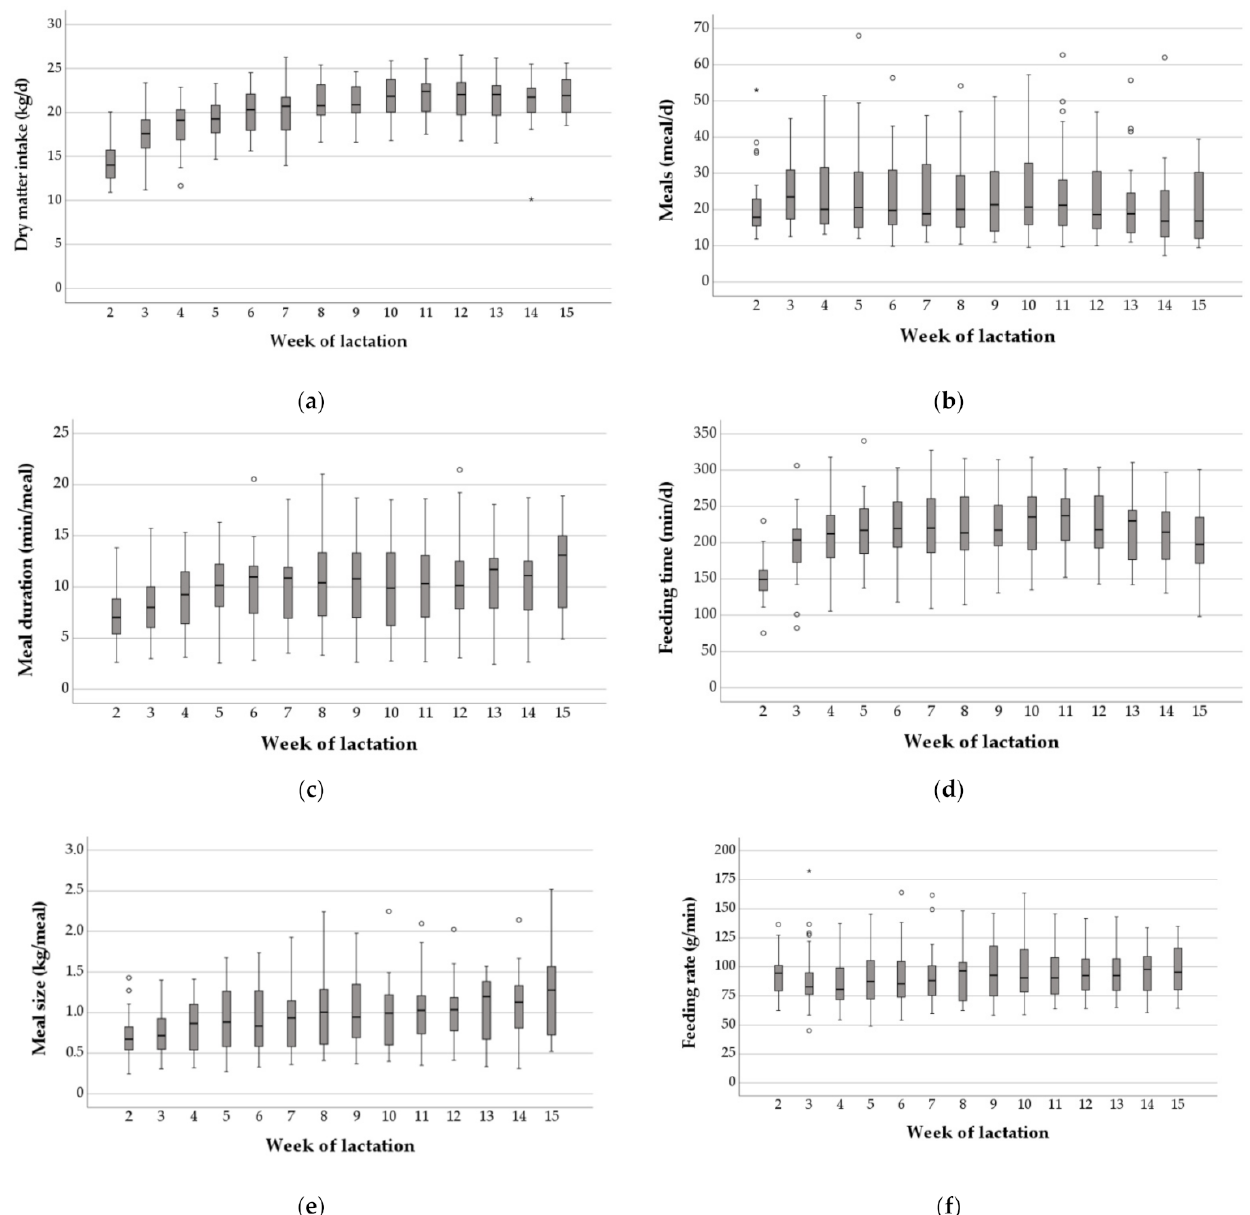
Figure 2. Dry matter intake (kg/day) ( a ), meal frequency (meals/d) ( b ), meal duration (min/meal) ( c ), feeding time (min/d) ( d ), meal size (kg/meal) ( e ) and feeding rate (g/min) ( f ), measured for all 28 cows between week 2 and 15 postpartum (p.p.). In each subfigure, the boxplots highlight, respectively, the median and upper and lower quartiles of each week. Small circles = outliers (1.5 × interquartile range (IQR)); asterisks = extreme values (3 ×